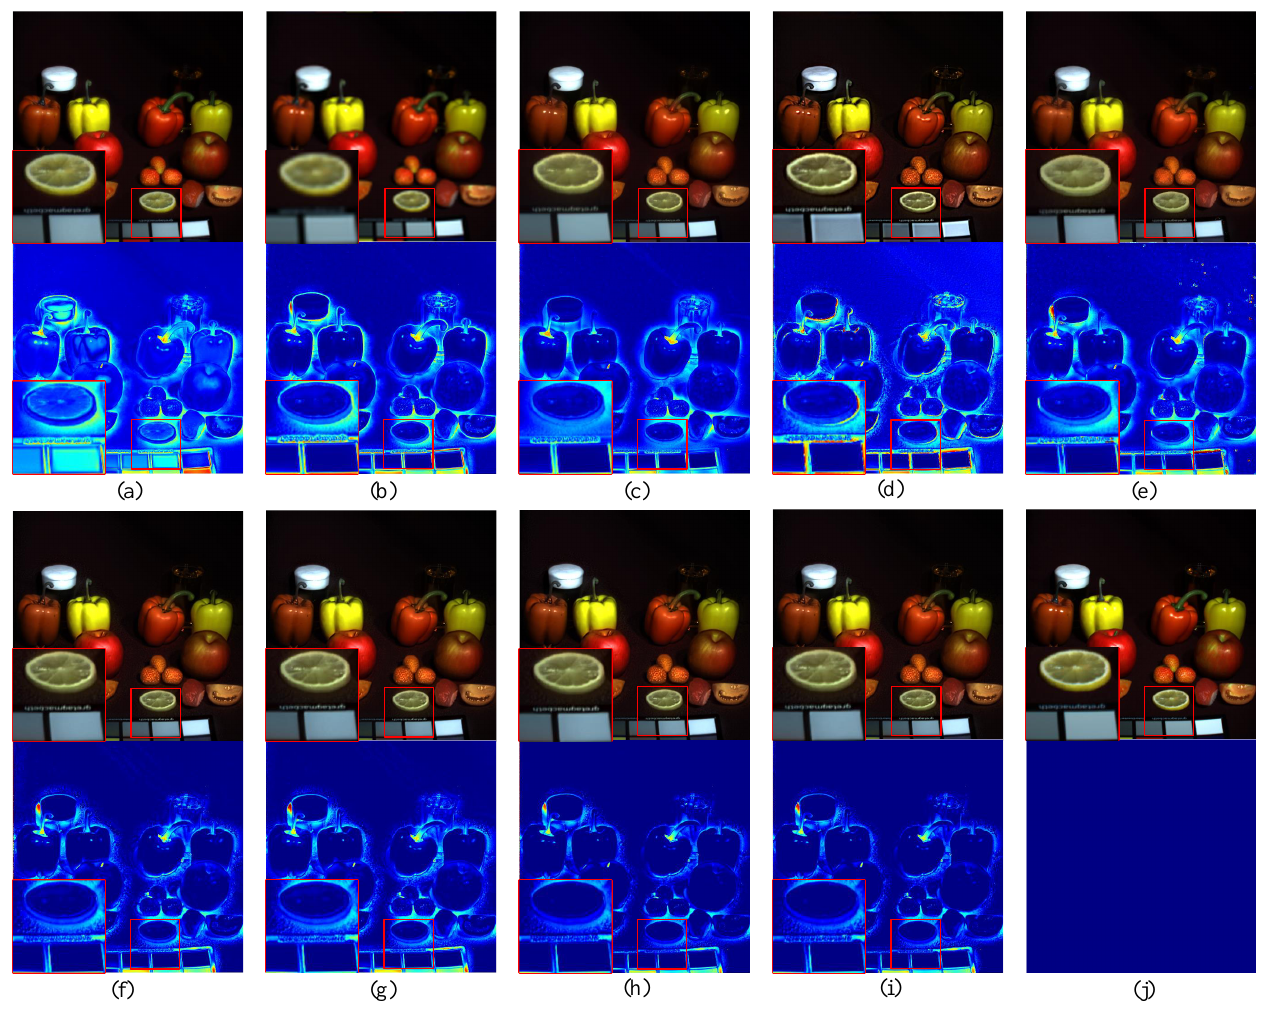
Figure 7. The visual results of different methods on the CAVE dataset. ( a ) CNMF; ( b ) Bayesian naive; ( c ) GFPCA; ( d ) PanNet; ( e ) DDLPS; ( f ) Original SeAM; ( g ) Original ResNet; ( h ) S 1 (RCAM) in the SSML framework; ( i ) S 2 (ResNet) in the SSML framework; ( j ) Ground truth. Note that the false color image is selected for clear visualization (red: 30, green: 20, and blue: 10). The even rows show the difference maps of the corresponding methods. Table 7. The quality indicator results of different methods on the Pavia Center data